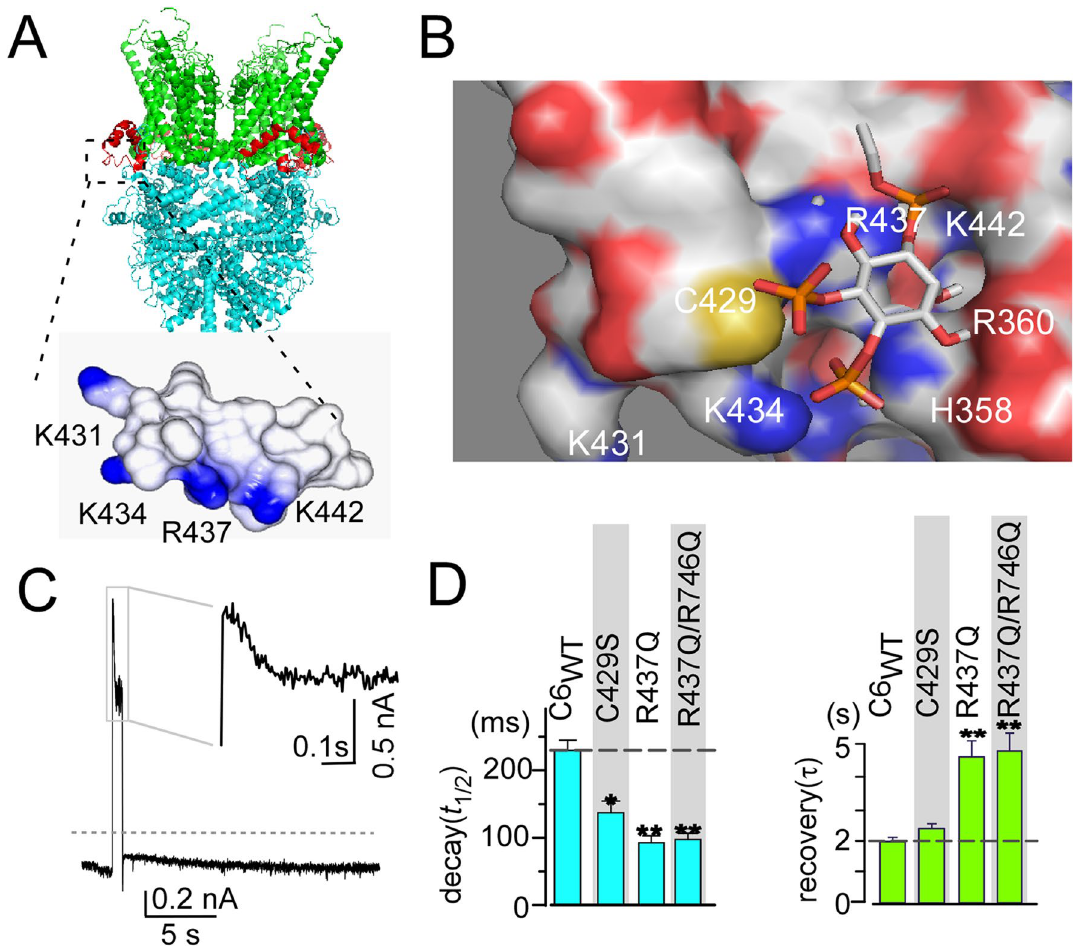
Figure 4. Simulation of PIP 2 docking to the pre-S1 domain. ( A , top) Ribbon diagram of TRPC6 (PDB: 6UZ8 33 ). The pre-S1 domain is depicted in red. (Bottom) Surface plot of the pre-S1 shoulder. ( B ) Surface representations of the arrangement of the short PIP 2 chain and the pre-S1 domain/shoulder with the linker segment between the ARD and pre-S1. ( C ) Trace showing the current through the double mutants R437Q/R746Q channel upon the activation of VSP. Gray dashed line indicates zero current level. ( D ) Summary of C429S and R437Q/R746Q kinetics to VSP activation for comparison with TRPC6 WT and R437Q ( n = 5 and n = 4 for C429S and R437Q/ R746Q, respectively). * p < 0.05 or ** p <